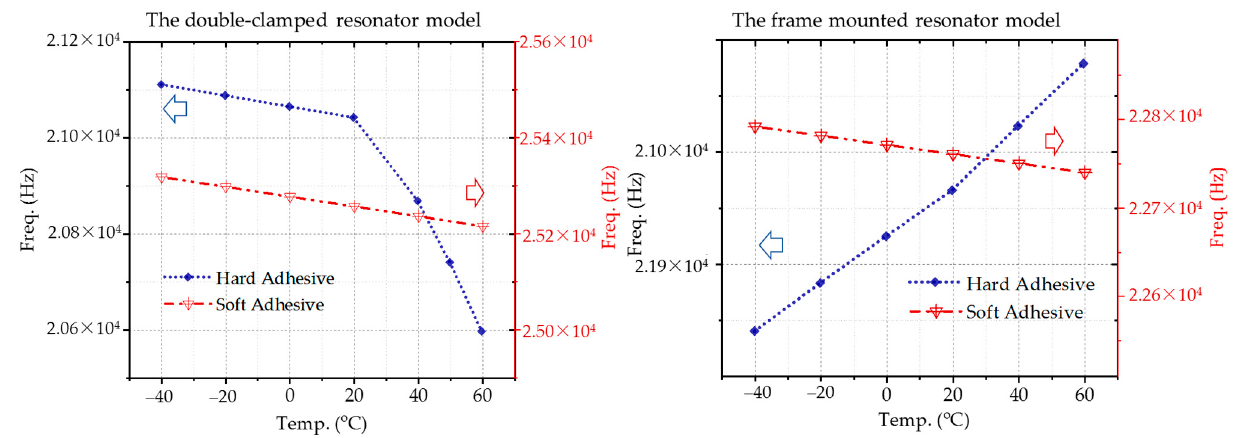
Figure 6. The resonator temperature characteristic with different adhesive in two